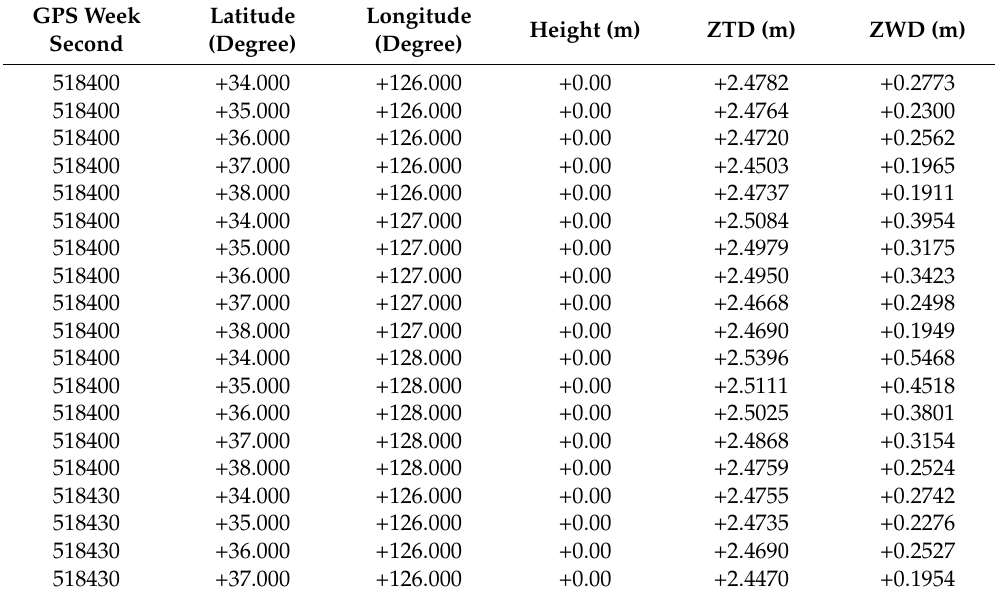
Table A5. Sample tropospheric corrections provided by SSR